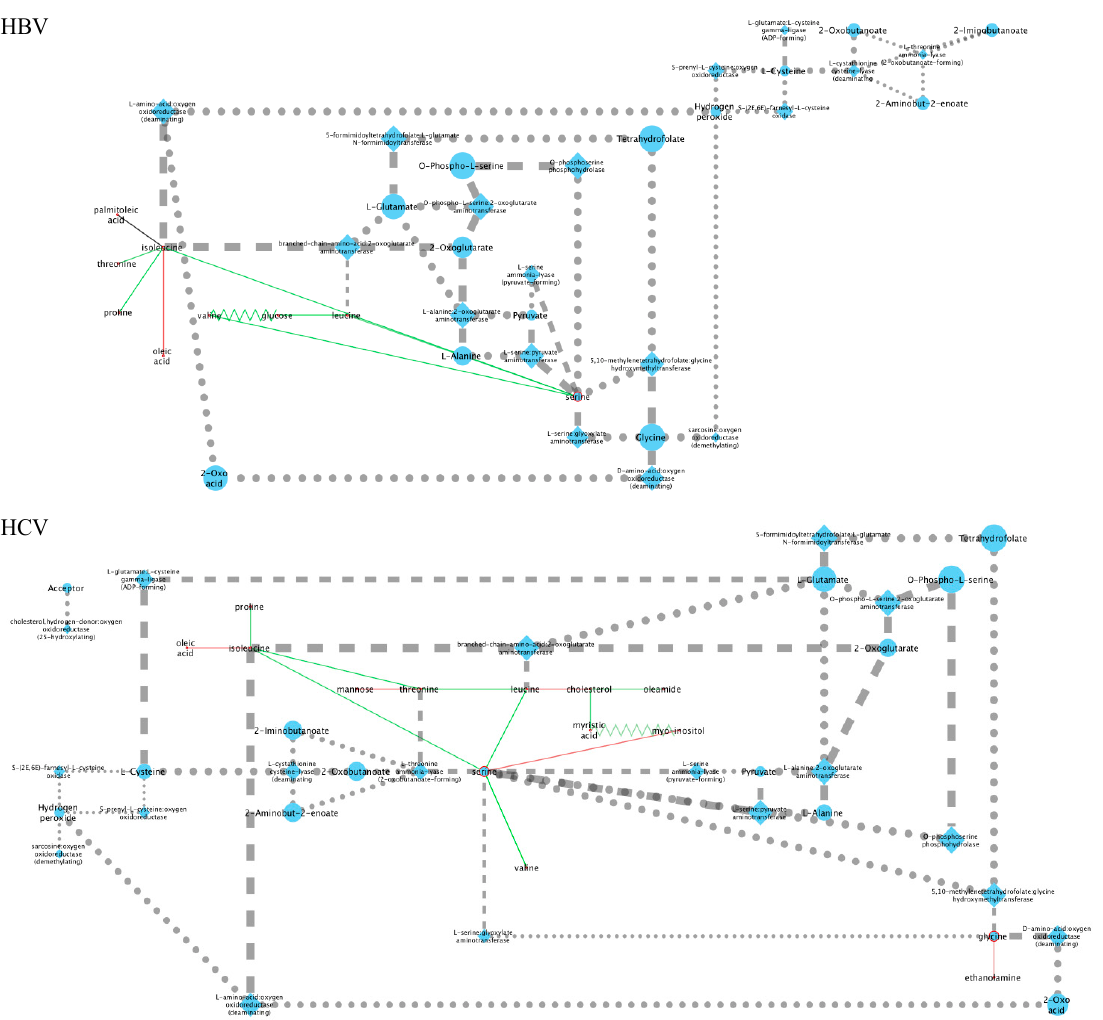
Figure A2. Integrated perturbation and metabolic network for the HBV and HCV plasma samples. Circle nodes represent metabolites, and diamonds represent enzymes. The same legend applies as in Figure A1.